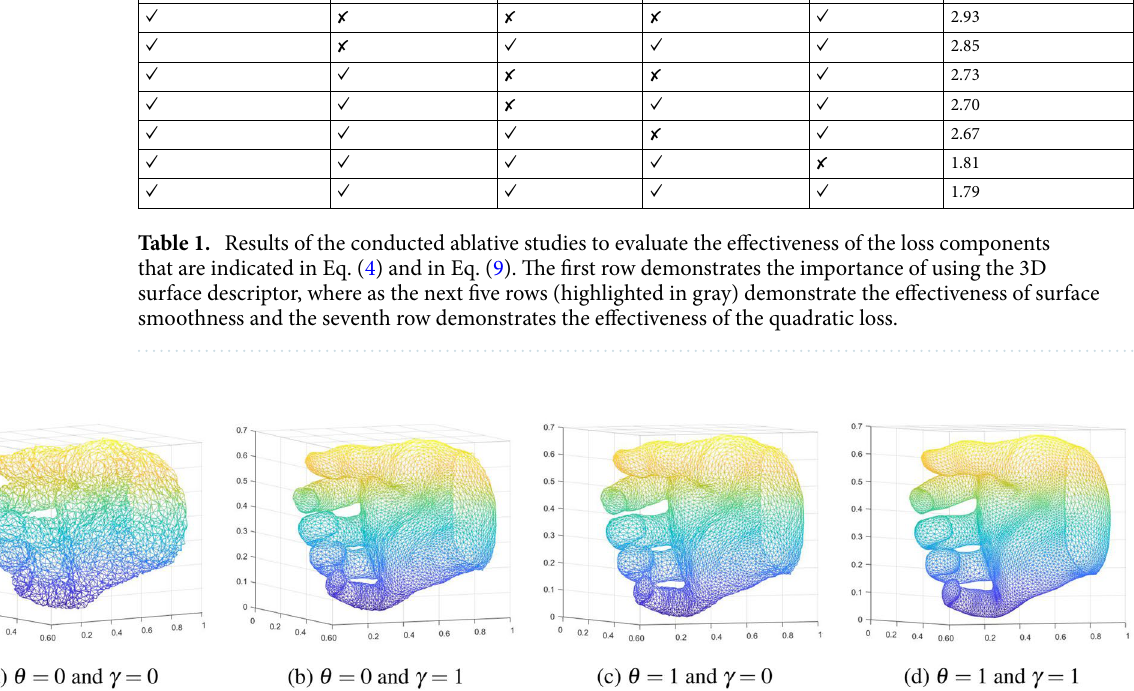
Figure 4. The qualitative results that were obtained by changing the parameters that are related to surface smoothness, in Eq.